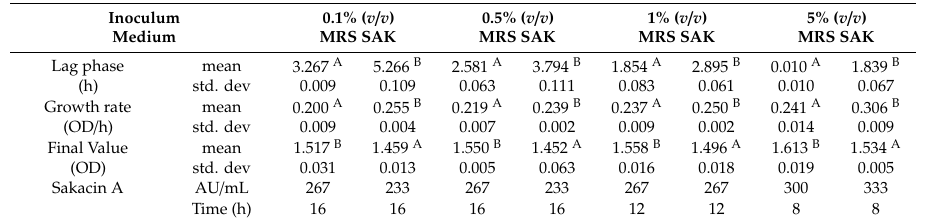
Table 2. L. sakei growth curves fitting parameters in MRS and SAK media di ff erently inoculated (from 0.1 to 5% v / v ). Inoculum Medium